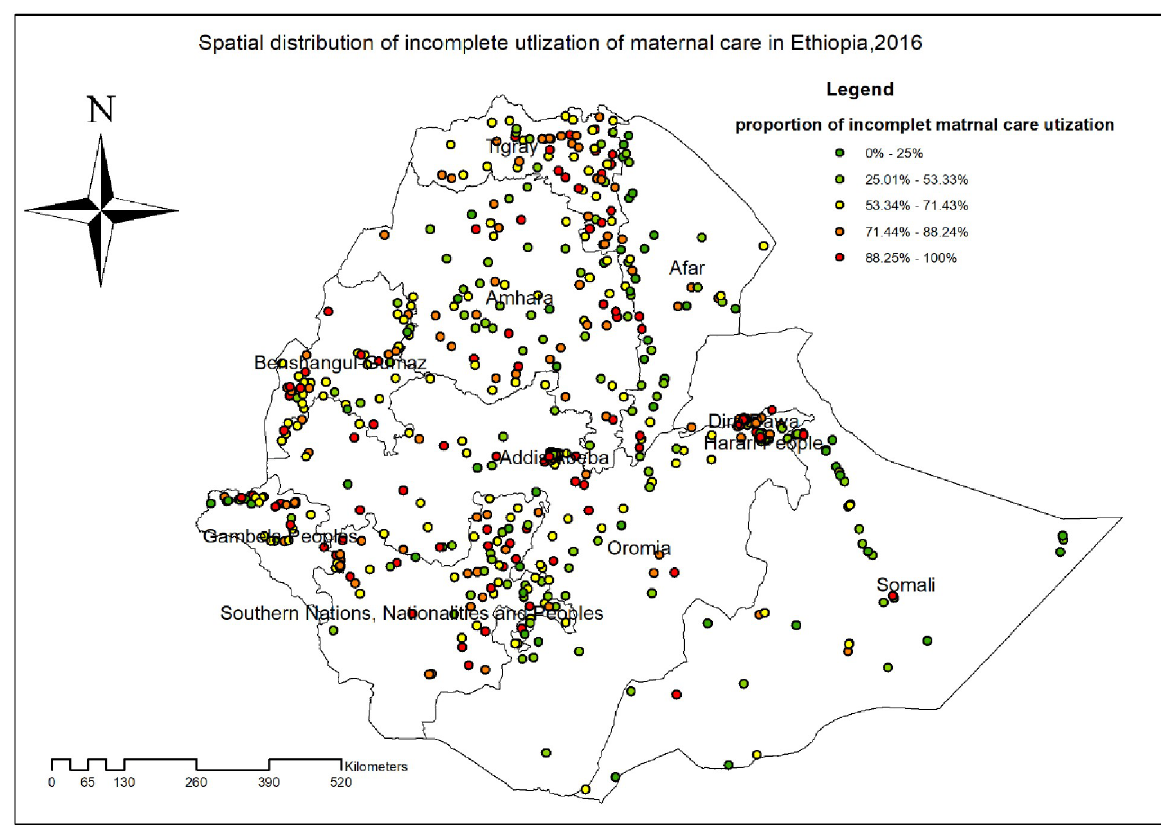
Fig 2. Spatial distribution of incomplete utilization of maternal continuum of care among reproductive aged women in Ethiopia, produced using Arc GIS version 10.7.